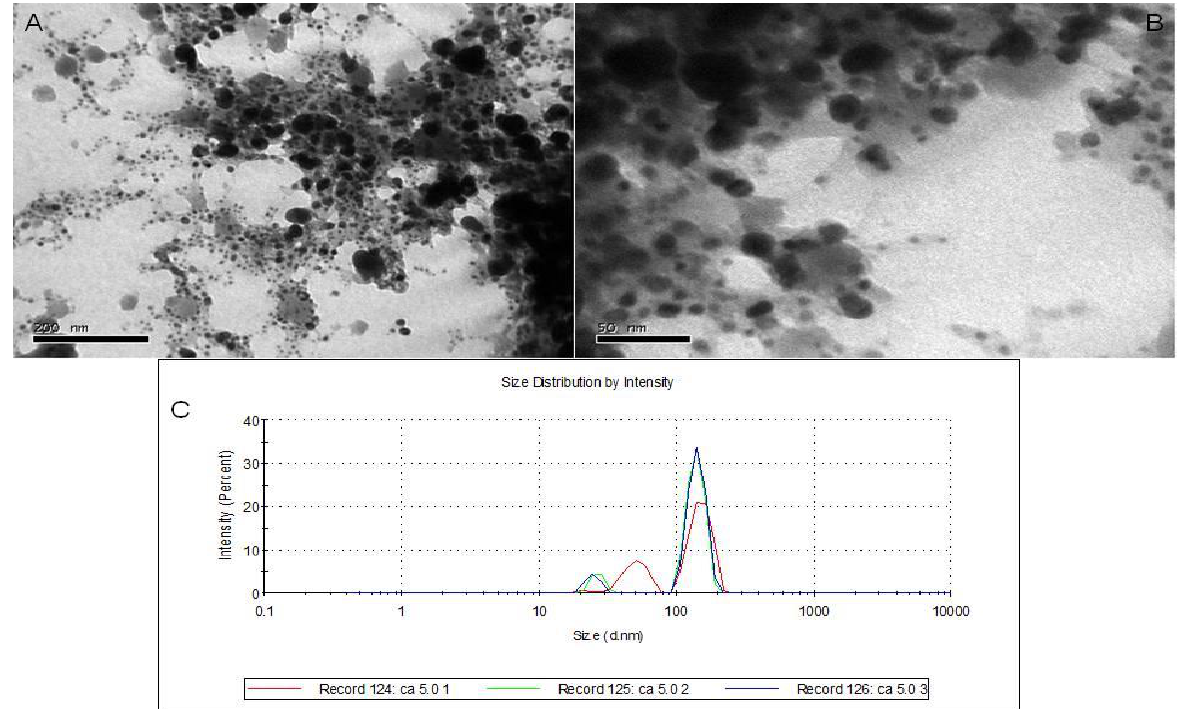
Figure 4. Characterization of AgNPs. ( A ) TEM image of AgNPs. The scale bar corresponds to 200 nm. ( B ) Closer view of the AgNPs. The scale bar corresponds to 50 nm. ( C ) Particle size distribution obtained by dynamic light scattering (DLS).